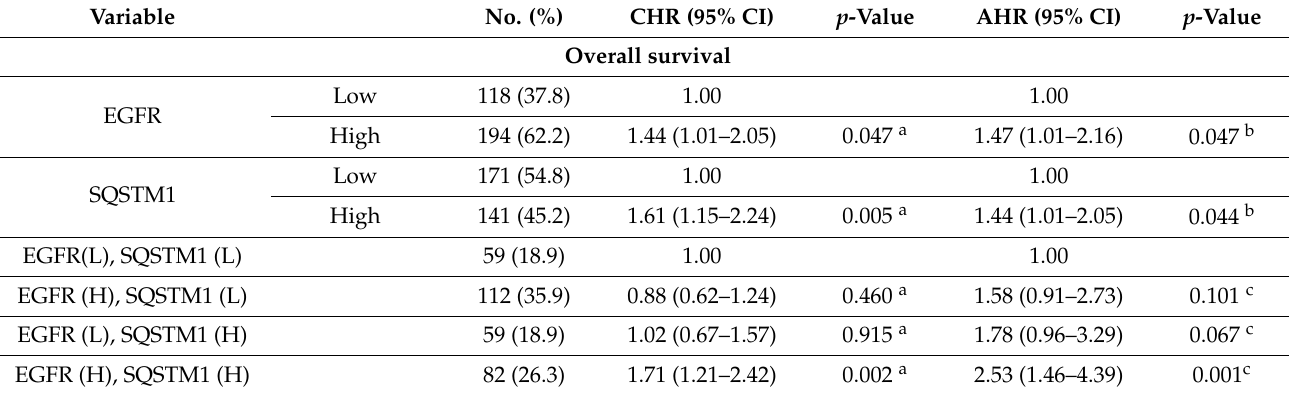
Table 4. The co-expression of EGFR and SQSTM1 in survival of oral cancer patients from TCGA database.